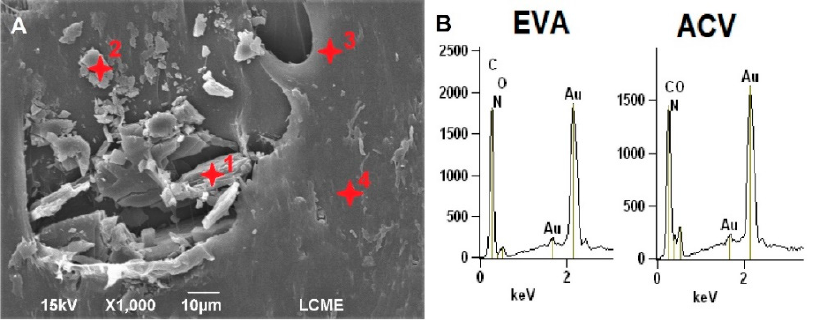
Figure 3. SEM images of the cross-section EVA-P20 ( A ) intravaginal rings samples with the EDS regions and the respective EDS spectra for carbon, oxygen, and nitrogen content in the EVA matrix and ACV particles ( B ).